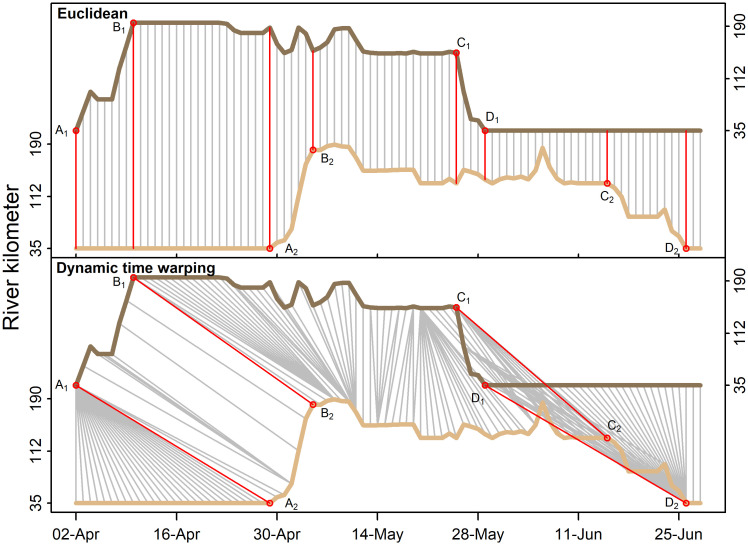
Visualization of matching two spawning phenologies via standard Euclidian (top panel) and dynamic time warping (bottom panel) methods.Single fish spawning phenologies are depicted as light brown (left axis units) and dark brown (right axis units). Time series are vertically offset for ease of visualization. Gray lines display daily positions matched using the respective algorithms. The arrival of each fish (subscript 1, 2) in the river (A) or spawning reach (B), and subsequent exits from the spawning ground (C) and river (D) are shown. Note that dynamic time warping allows these spawning phenologies, offset in time, to be matched, while the Euclidean method matches only those points that co-occur in time.